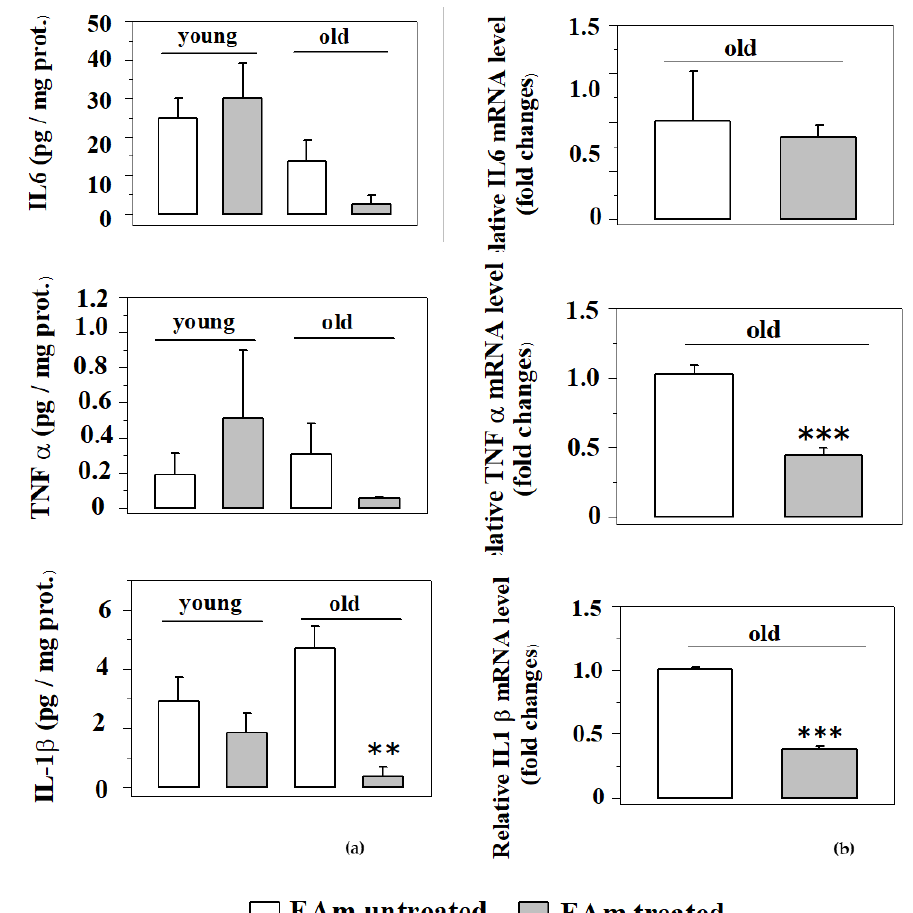
Figure 7. Effects of EAm treatment on the endogenous production of pro-inflammatory cytokines in the cortex of mice. The amount of the cytokines was measured as protein content ( a ) and as mRNA levels ( b ) in the respective mice (N = 4 animals/group). ( a ) Histograms show the mean values of protein expression (pg/mg) of TNF-α, IL-6 and IL-1β. Data are expressed as an average ± SEM (One Way ANOVA followed Tukey’s Multiple Comparison test ** p < 0.01 versus untreated mice). ( b ). Histograms show the mean values of mRNA levels of TNF-α, IL-6 and IL-1β. Data are expressed as mean ± SEM (Student’s t-test *** p < 0.001 versus old untreated mice).